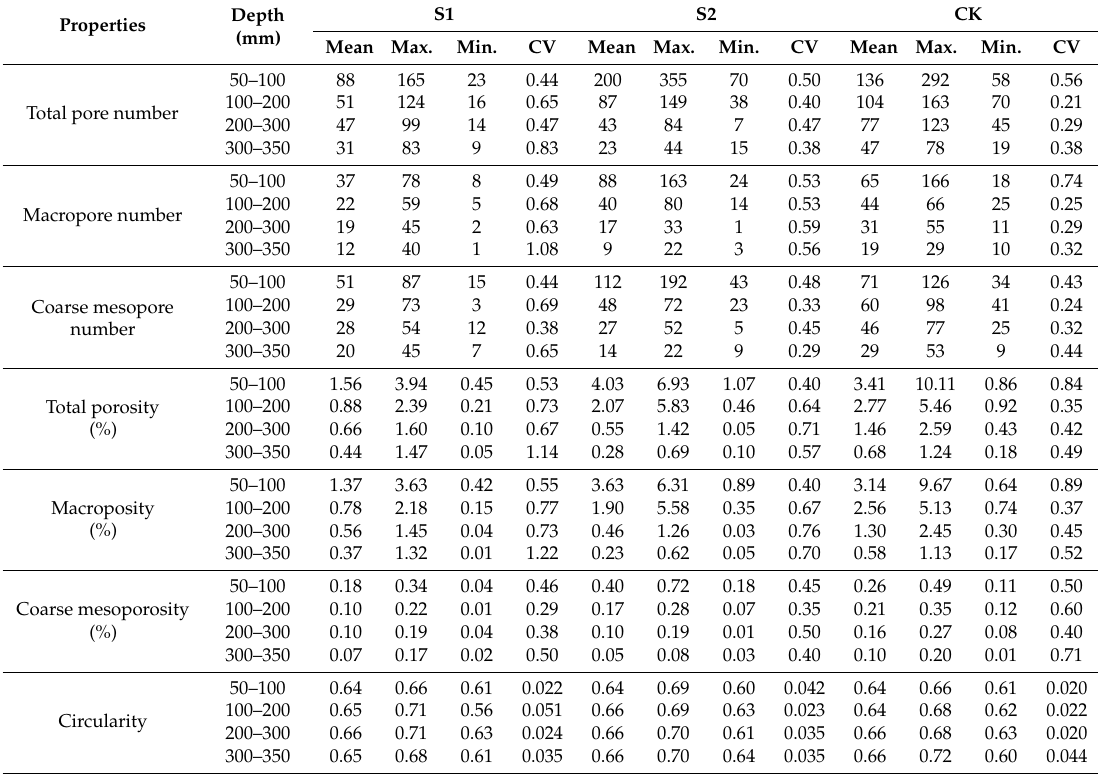
Table 2. Descriptive statistics of soil pore feature under S1 irrigated sewage for 25 years, S2 irrigated with sewage for 52 years and CK irrigated with groundwater at the 50–100 ( n = 18), 100–200 ( n = 30), 200–300 ( n = 30) and 300–350 ( n = 15) mm